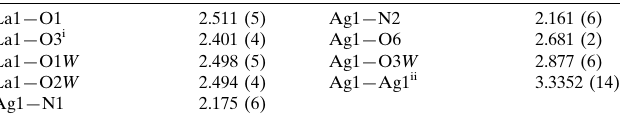
Selected bond lengths (A˚ ).